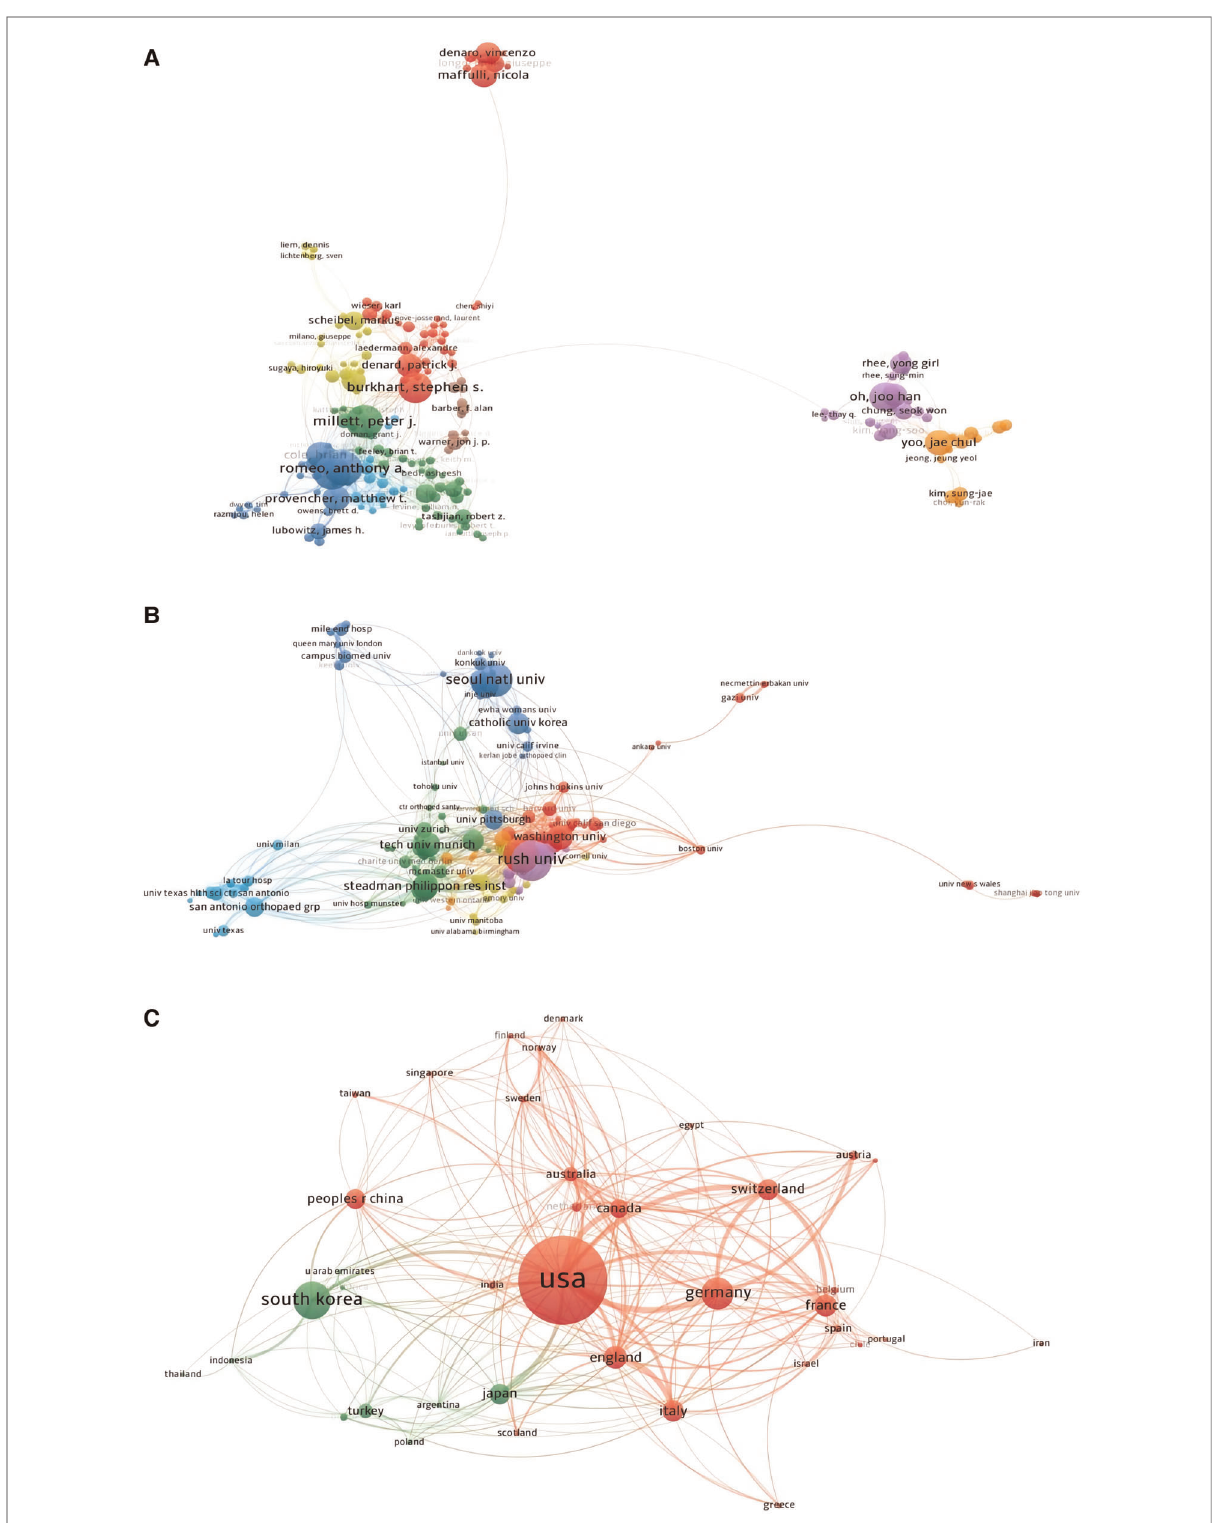
FIGURE 9 Co-authorship analysis of authors, institutions, and countries (analysis based on the arthroscopic therapy of rotator cuff diseases related publications from 2002 to 2021). ( A ) Mapping of the 174 identi fi ed the most relevant authors. ( B ) Mapping of the 148 identi fi ed the most relevant institutions. ( C ) Mapping of the 38 identi fi ed most relevant